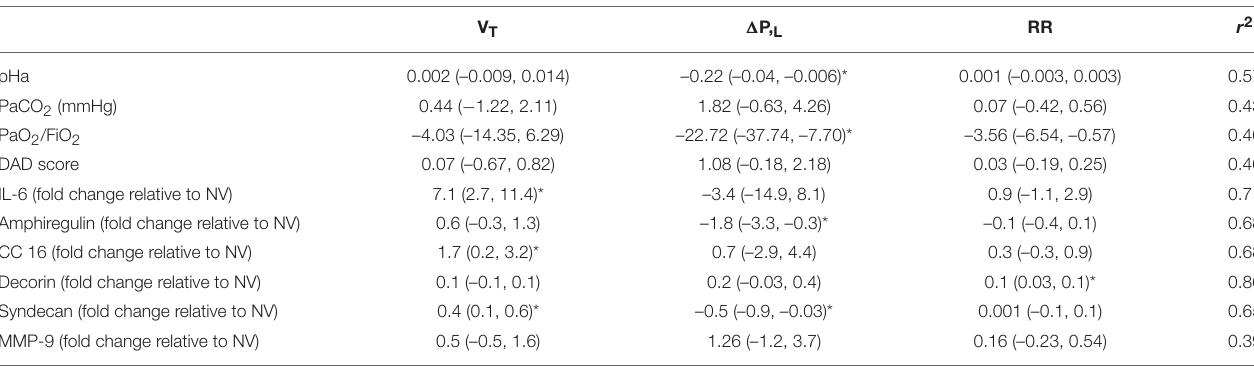
TABLE 2 | Coefficients of multiple linear